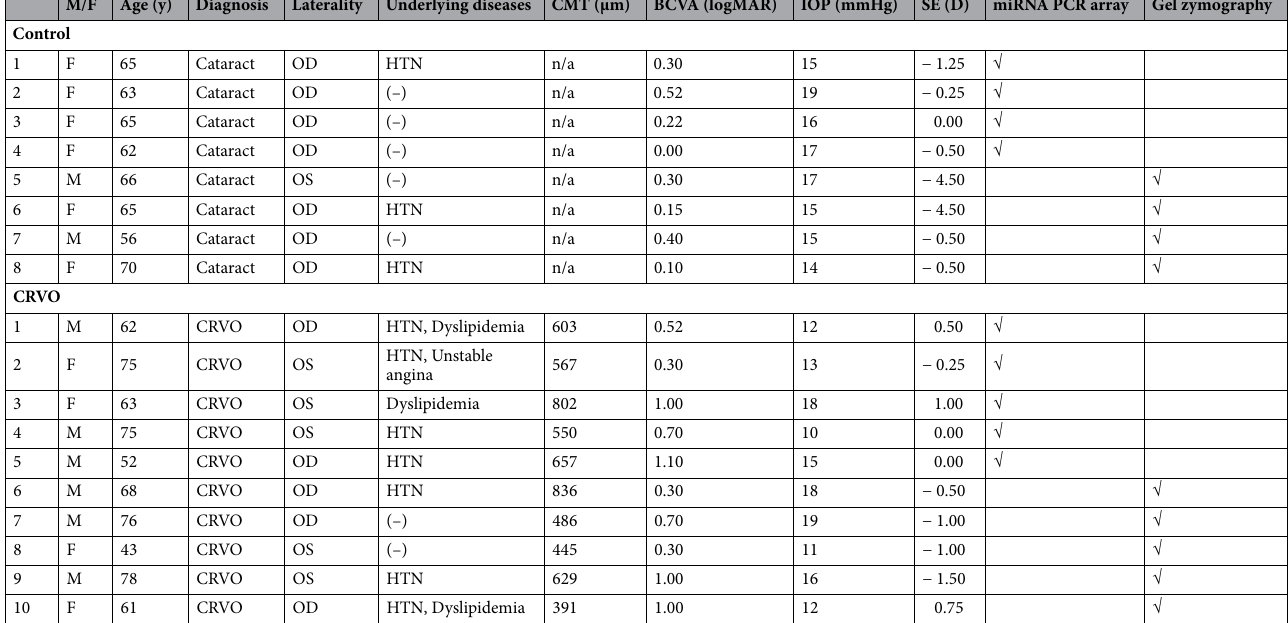
Table 1. Clinical characteristics and ophthalmic data of control subjects and patients with central retinal vein occlusion. BCVA, Best-corrected visual acuity; CMT, central macular thickness; CRVO, central retinal